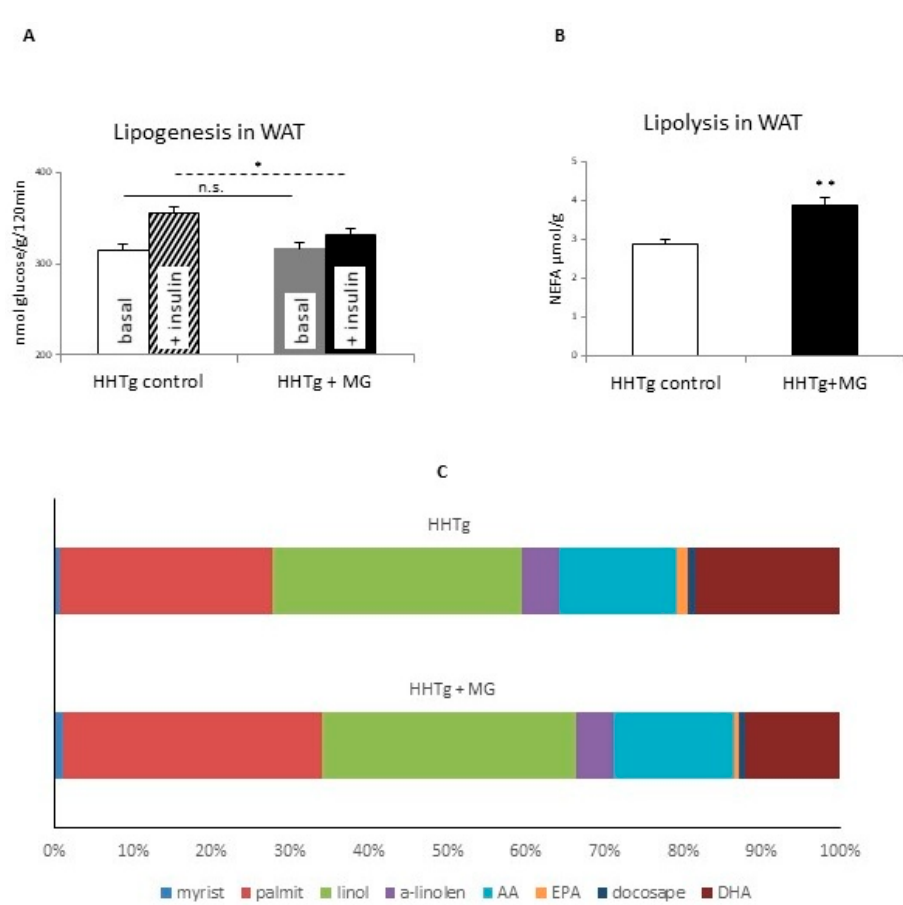
Figure 1. Basal and insulin-stimulated 14 C-U glucose incorporation into lipids ( A ), adrenaline stimulated lipolysis ( B ) and phospholipid fatty acid composition in visceral adipose tissue ( C ) in HHTg (hereditary hypetriglyceridaemic) rats treated with methylglyoxal compared to control HHTg rats. Data are expressed as means (SD) and analyzed using the two-tailed unpaired Student’s t -test. * denotes p < 0.05, ** denotes p < 0.01, n.s. denotes non-significant.